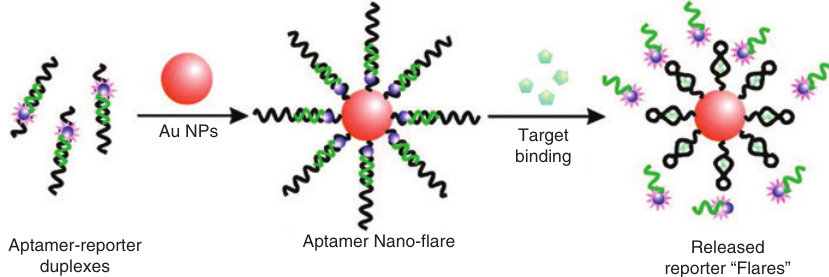
Figure 3: Aptamer nanoflares are AuNPs functionalized with thiol-terminated aptamer sequences hybridized to a short complementary Cy5- labeled reporter strand. The reporter was displaced when the presence of target molecule induced a conformational change of the aptamer. Reprinted with permission of Ref. [40]. © Copyright 2009 American Chemical